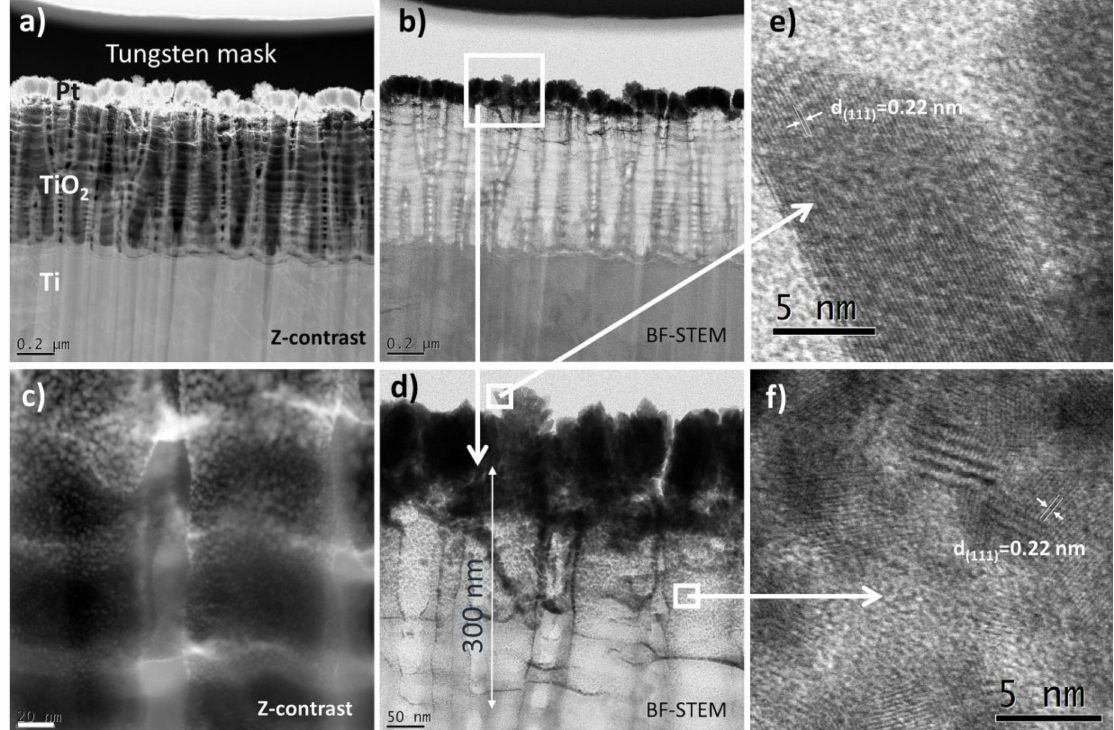
Figure 2. Cross-sectional view of titania nanotubes (25 V, 450 ◦ C / 1 h) decorated with 0.2 mg cm − 2 Pt. STEM images obtained via Z-contrast ( a , c ) and BF-contrast ( b , d ), as indicated. ( e ) and ( f ) shows HR STEM images of the single nanotube and Pt nanoparticles attached to the walls of